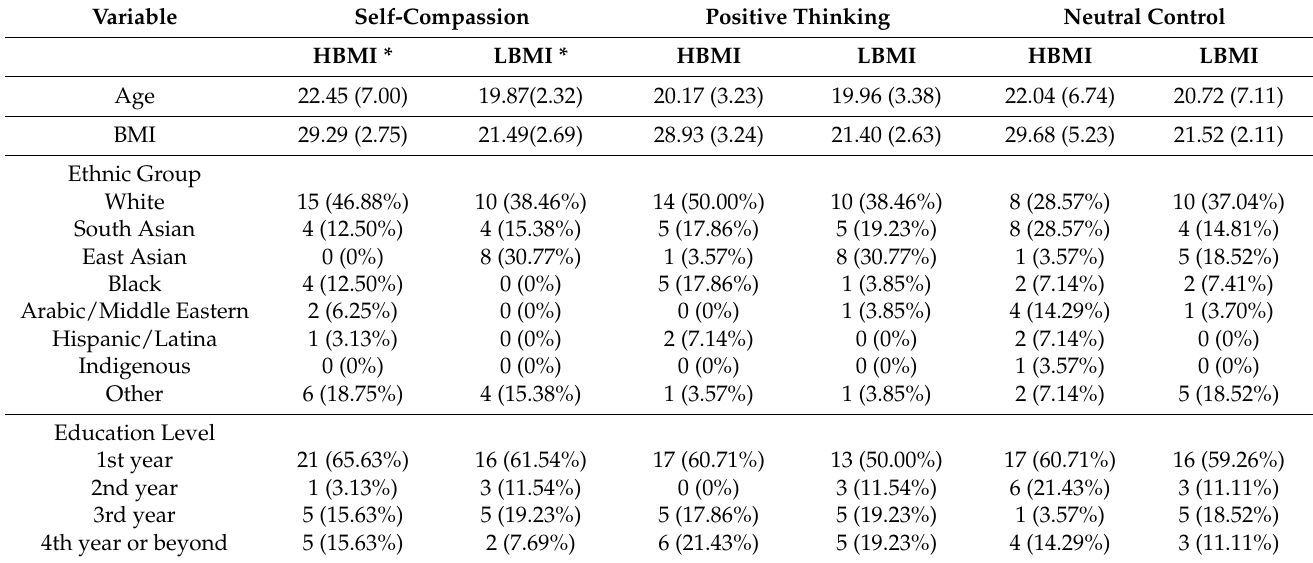
Table 1. Demographic Characteristics as a Function of Experimental Condition and Weight